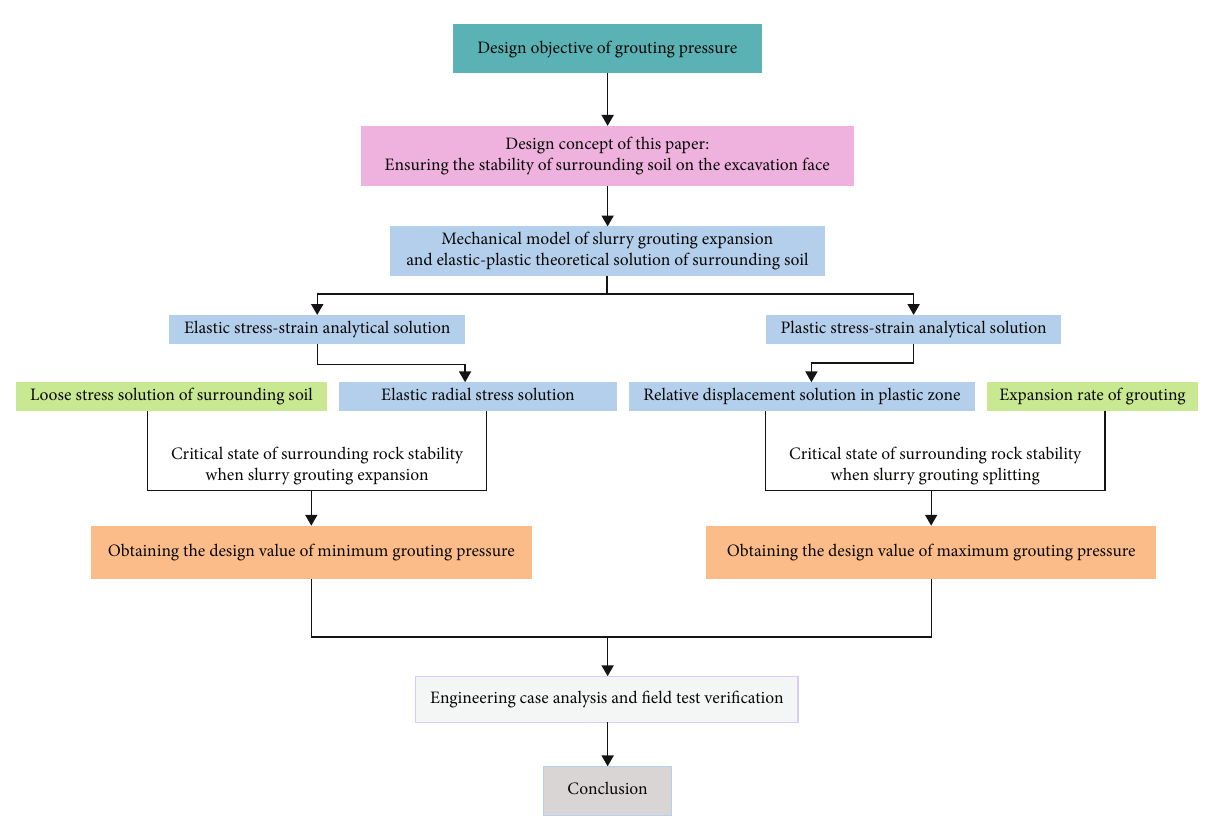
Figure 1: Design idea map of slurry grouting